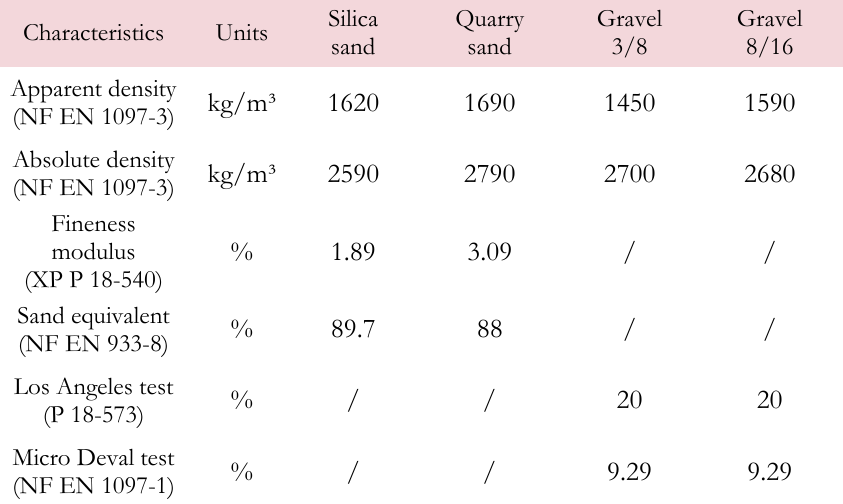
Table 3: Characteristics of aggregates [47–51].